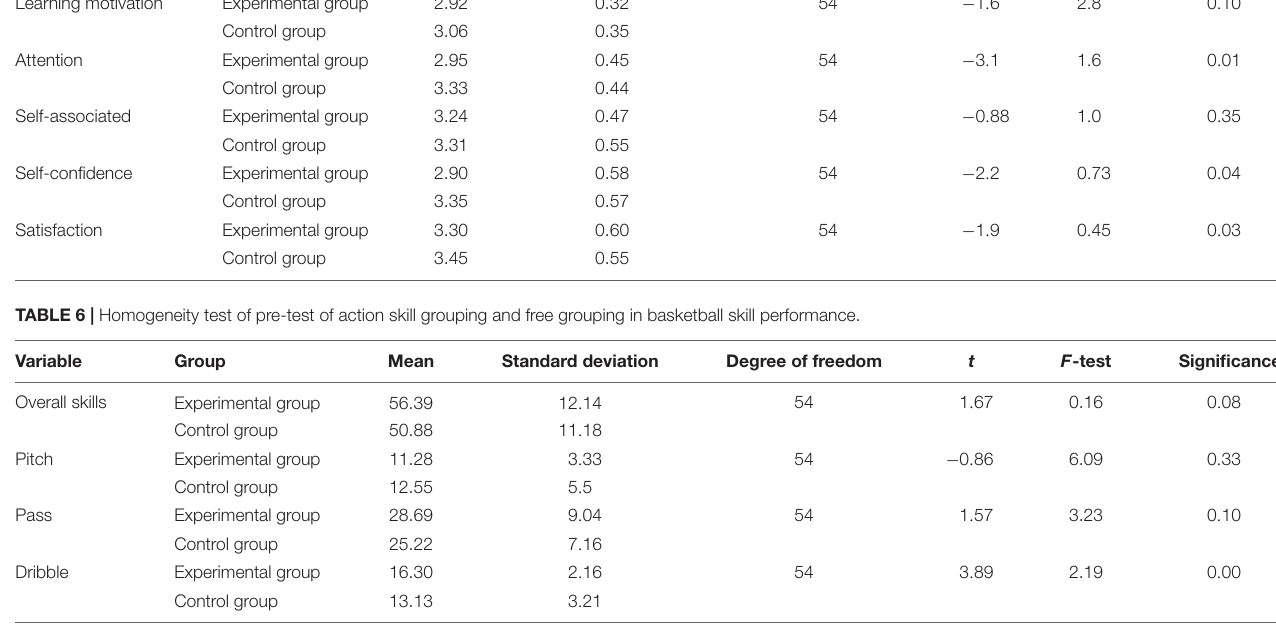
TABLE 5 | Homogeneity test of action skill grouping and free grouping ARCS learning motivation pre-test. Variable Group Mean Standard deviation Degree of freedom